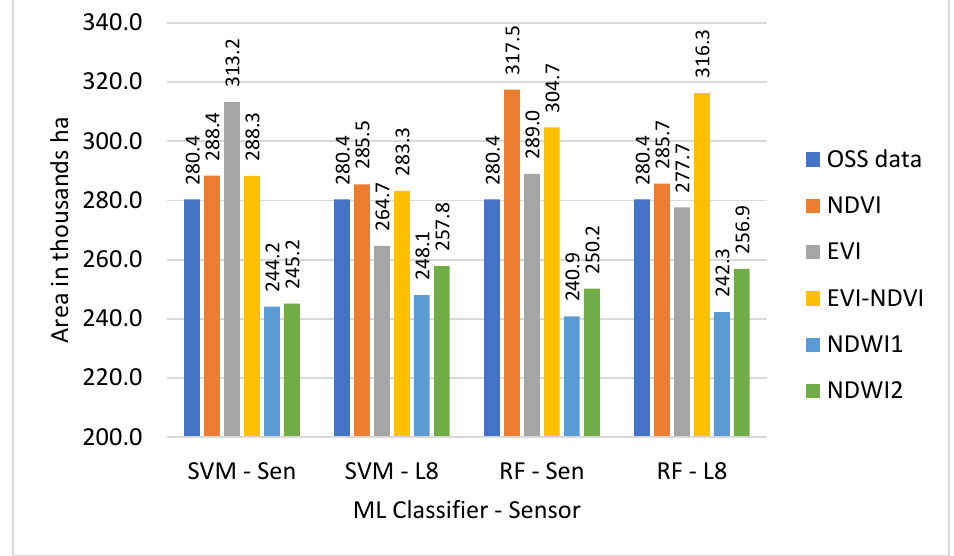
Figure 16. Difference between the total area of OSS data and classified area by sensors, classifiers, and indices.